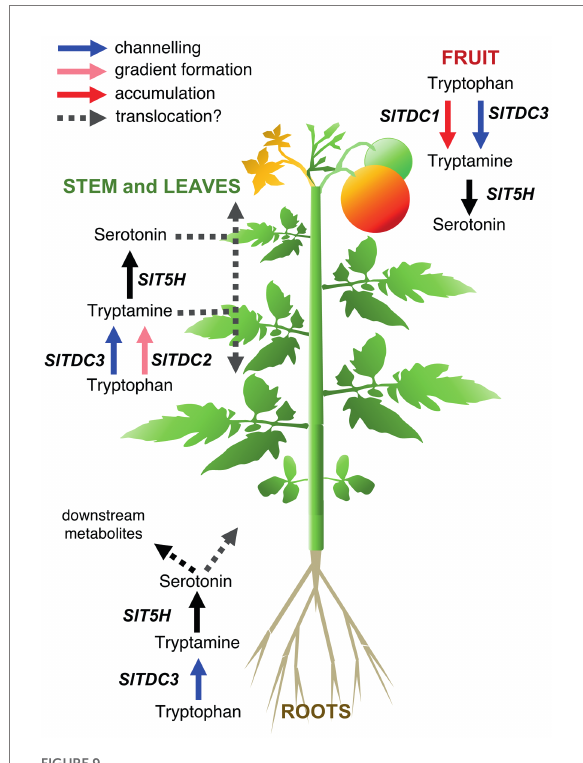
FIGURE 9 Proposed model for the functional interactions of tomato serotonin pathway genes in different organs of the Micro-Tom plant. Different functions of the TDC genes that we hypothesize are represented by arrows with different colors: SlTDC1 converts tryptophan to tryptamine for accumulation (red arrow) in the immature fruit, SlTDC3 works in cooperation with SlT5H to channel (blue arrows) tryptophan to serotonin in fruit, aerial organs and roots. SlTDC2 works together with SlT5H to generate the indolamine accumulation gradient along the aerial growth axis (pink